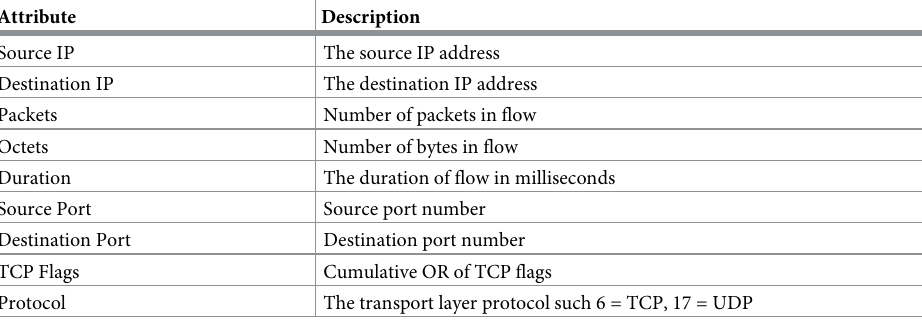
Table 1. Detailed attributes for Netflow v5 flow